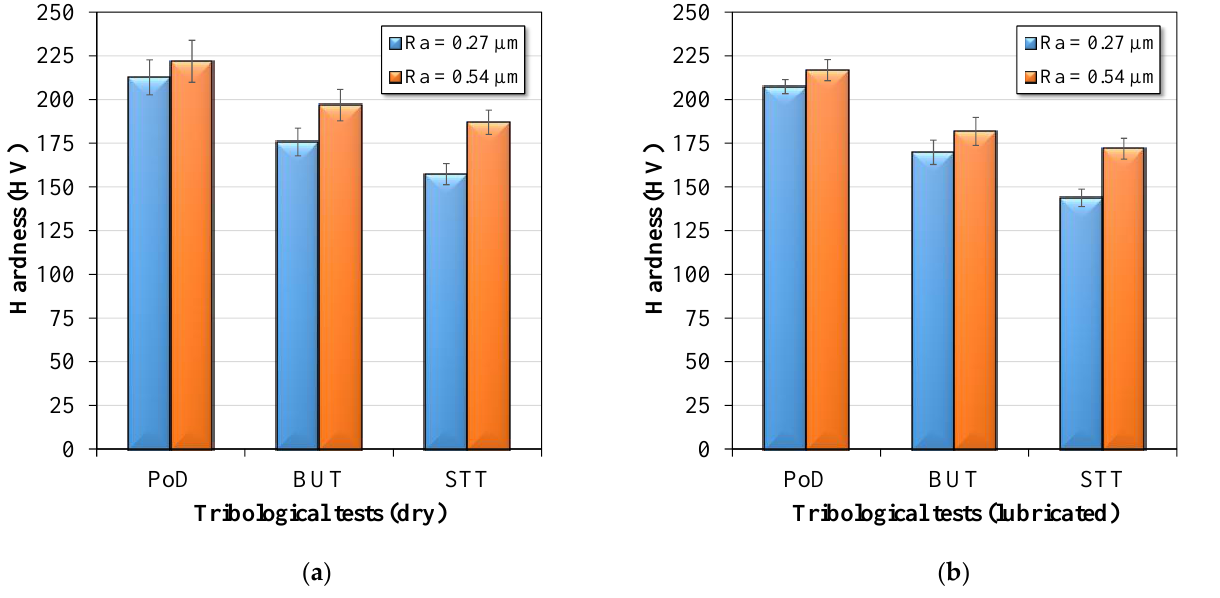
Figure 15. Average hardness measured below wear surface: ( a ) dry contact and ( b ) lubricated contact.